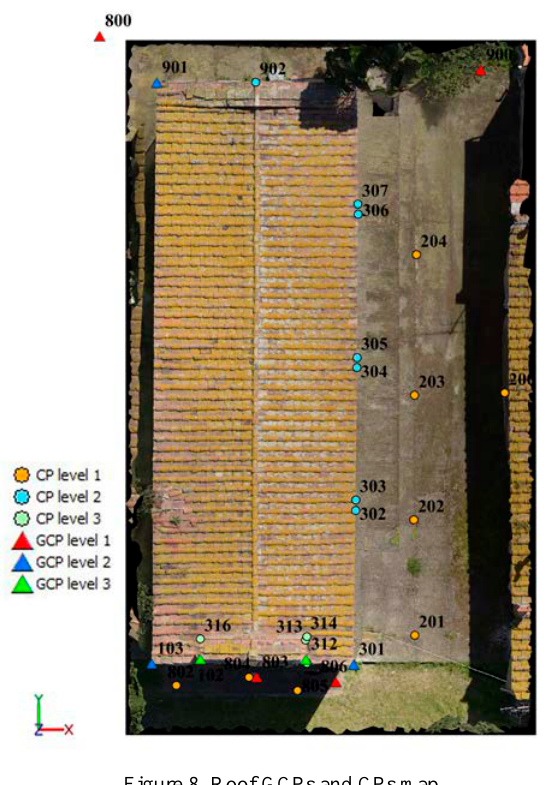
Figure 8. Roof GCPs and CPs